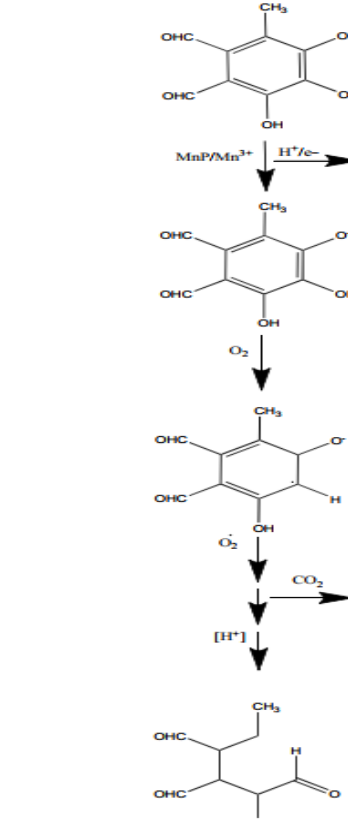
15 of 23 Figure 7. Fungal pigment cycloleucomelone and anthraquinone dye RBBR. If we take a look at the structures of pigments produced by fungi and synthetic dyes, we can see that most of them contain a phenolic ring bound to the hydroxy group (for a closer look, refer to [2]) . For example, simple flavipin, a yellow pigment produced by Epicoccum purpurescens and Chaematomium globosum [2,166], has a phenyl group bonded to three hydroxyl groups (Figure 8b). Under the catalysis of MnPs, one of those hydroxyl groups can be oxidized, and Mn 3+ is reduced to Mn 2+ . As the reaction goes further, with the series of oxidoreduction reactions, the phenolic ring would break down, causing the